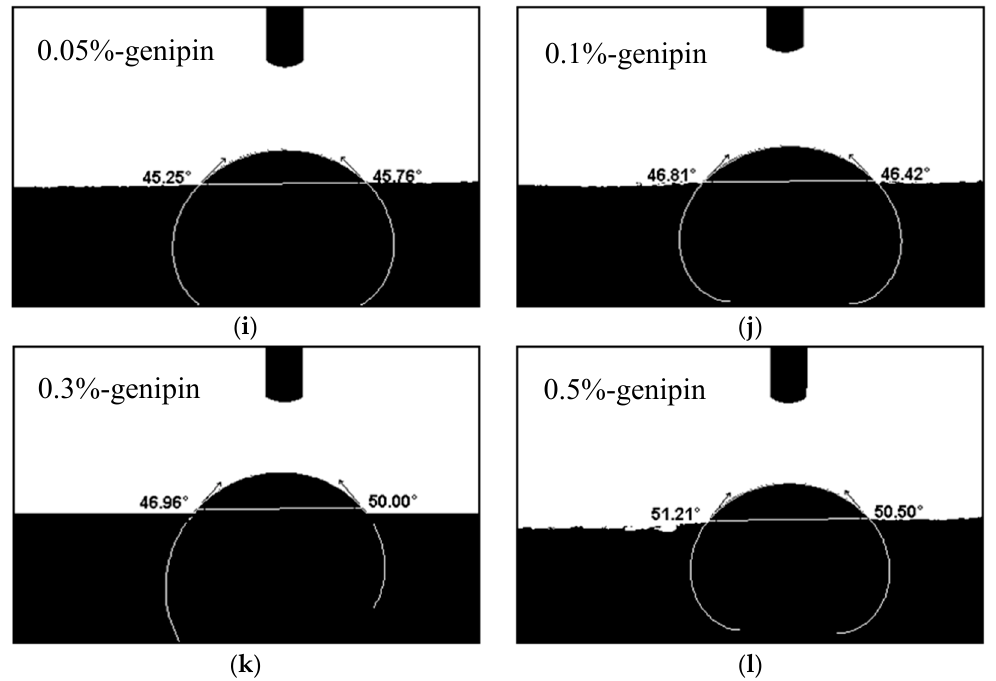
Figure 5. The contact angles for the various blend films: ( a ) 0.05%-TG, ( b ) 0.1%-TG, ( c ) 0.3%-TG, ( d ) 0.5%-TG, ( e ) 0.05%-CaCl 2 , ( f) 0.1%-CaCl 2 , ( g ) 0.3%-CaCl 2 , ( h ) 0.5%-CaCl 2 , ( i ) 0.05%-genipin, ( j ) 0.1%-genipin, ( k ) 0.3%-genipin, and ( l ) 0.5%-genipin.